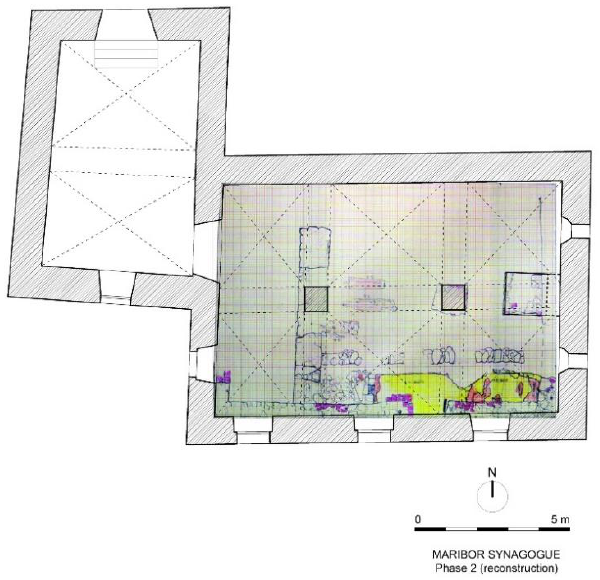
Figure 18. Archaeological sketch of the findings inserted into the ground plan of the second synagogue phase. Archaeological sketch: Mihela Kajzer Cafnik. The hall was extended towards the west, which is why the western wall of the initial building had to be pulled down. Part of that wall was used as a foundation for one of the two columns, dividing the new space into six square vault bays and two naves. The foundation for the Tora Ark can be seen on the eastern side. A few tombstones, located between the two columns, were also revealed, which turned out to be of later, Christian origin.